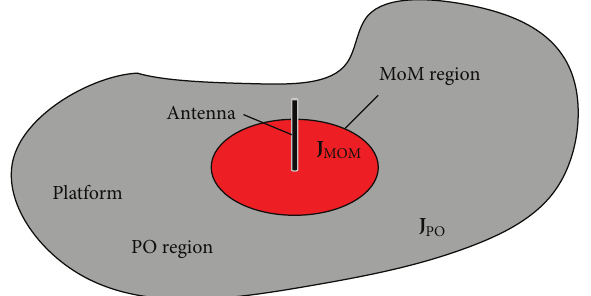
Figure 1: The structure is divided into MoM region and PO